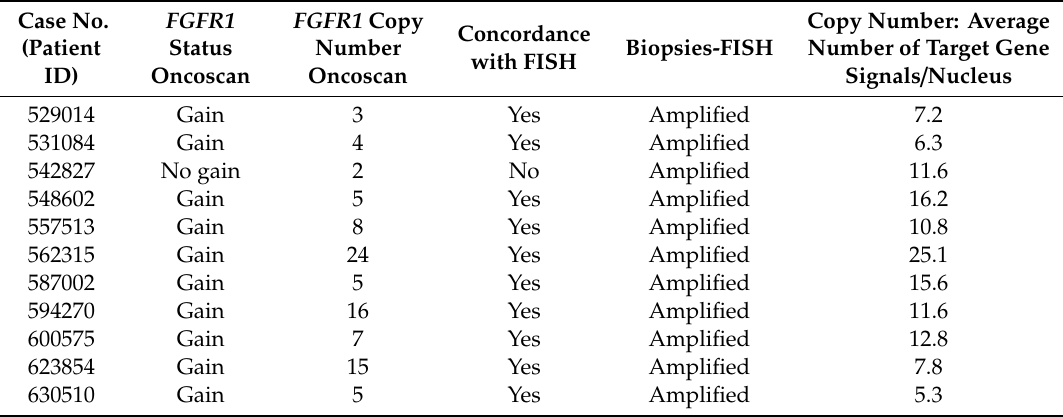
Table 3. FGFR1 amplification status concordance between FISH and Oncoscan